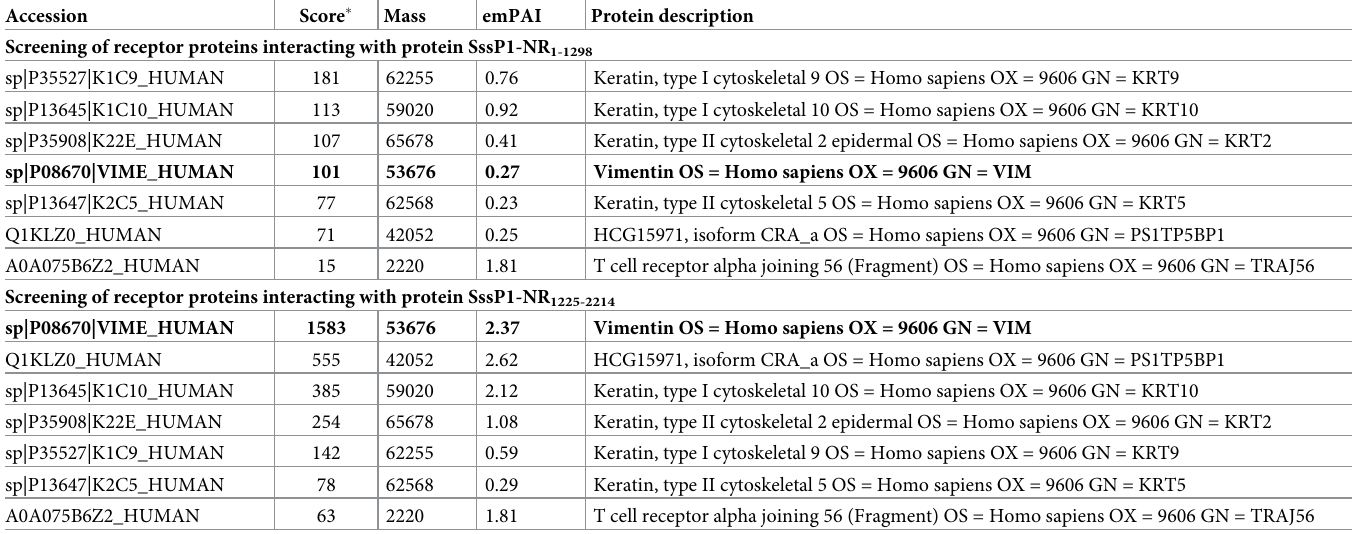
Table 1. The potential receptor proteins of HBMEC were screened jointly by SssP1-NR 1-1298 and SssP1-NR 1225-2214 binding. Accession Screening of receptor proteins interacting with protein SssP1-NR 1-1298